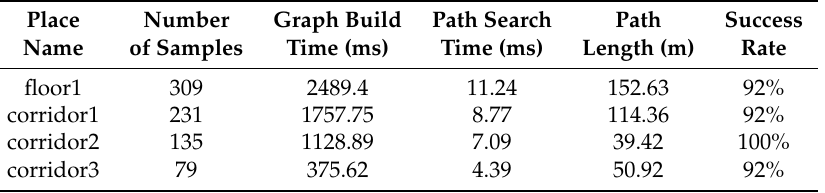
Table 7. Optimized the number of samples.